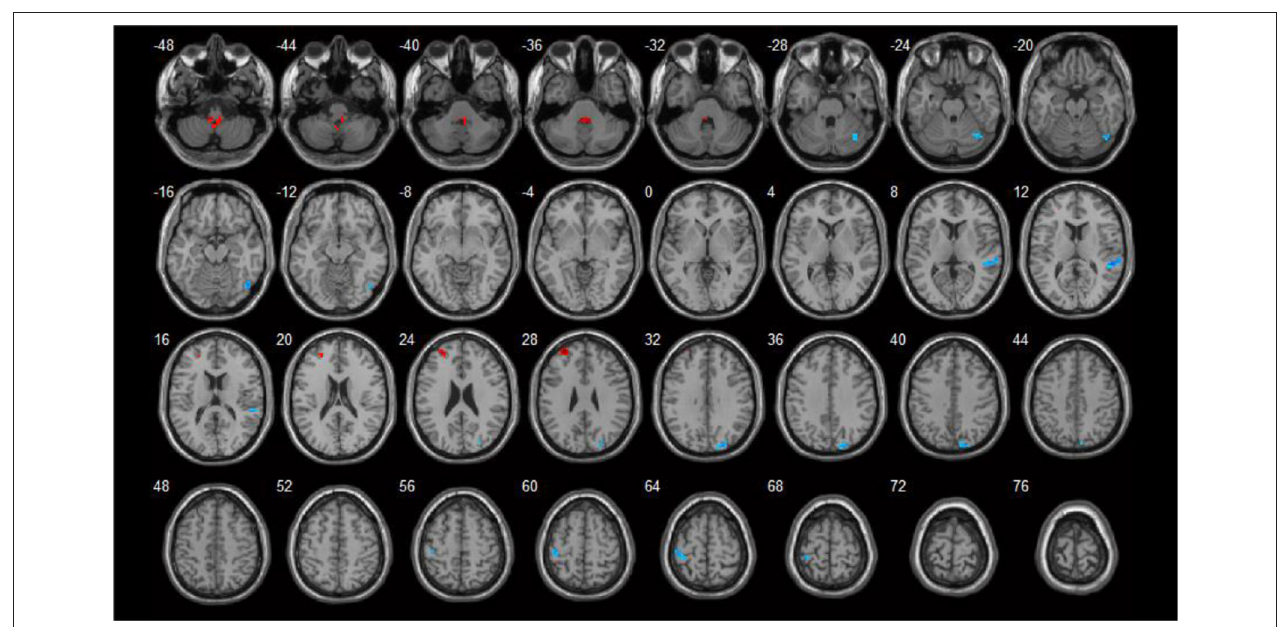
FIGURE 4 | Correlations between ReHo values and HAMD scores ( p < 0.05). Blue spots showed areas with negative correlation with